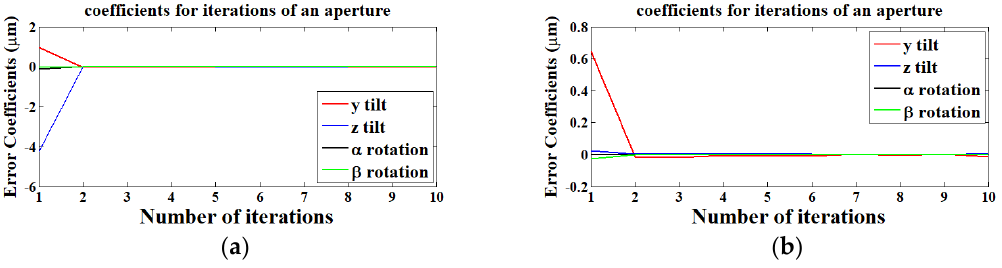
Figure 8. ( a , b ) The change of the relative motion errors of two sub-apertures in 10 iterations.